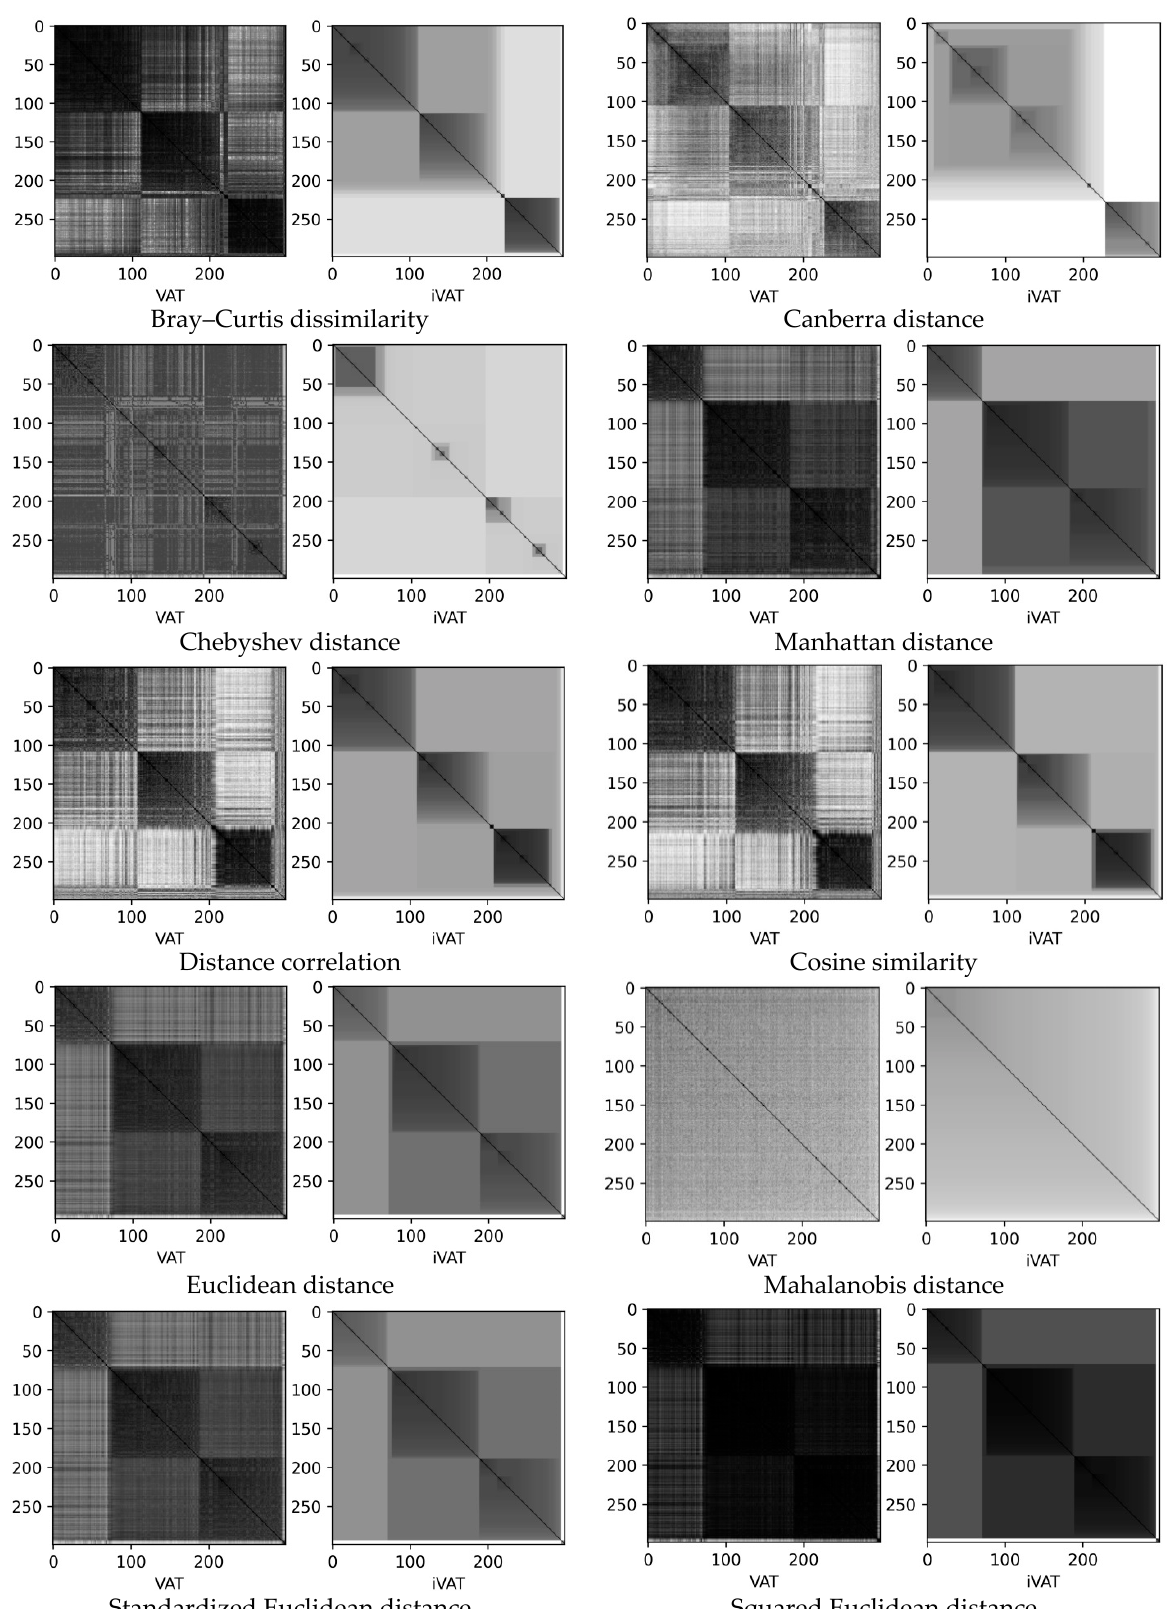
Figure A6. Microchips 1526IE10_002, three-batch mixed lot. Cluster heat map.